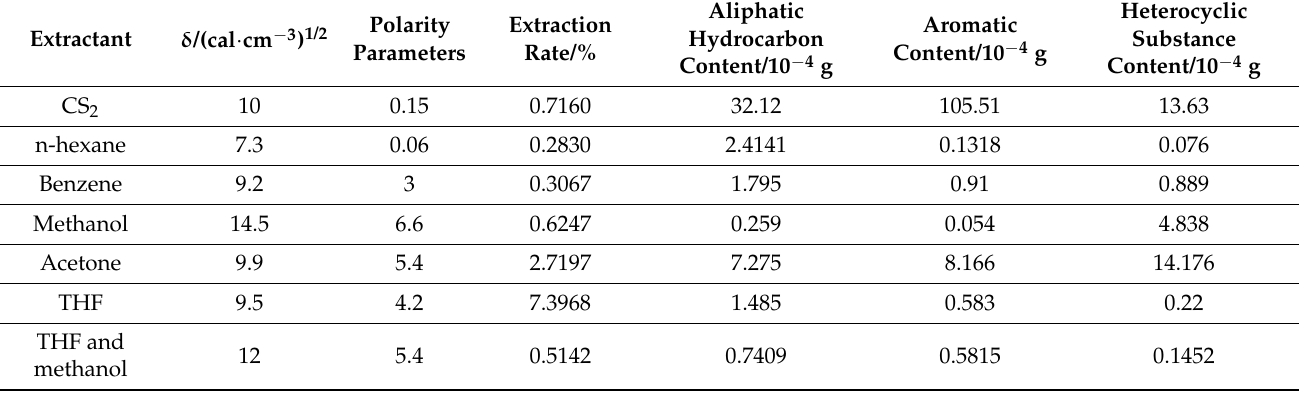
Table 1. Extraction rate and extractant composition of Shenfu coal in graded